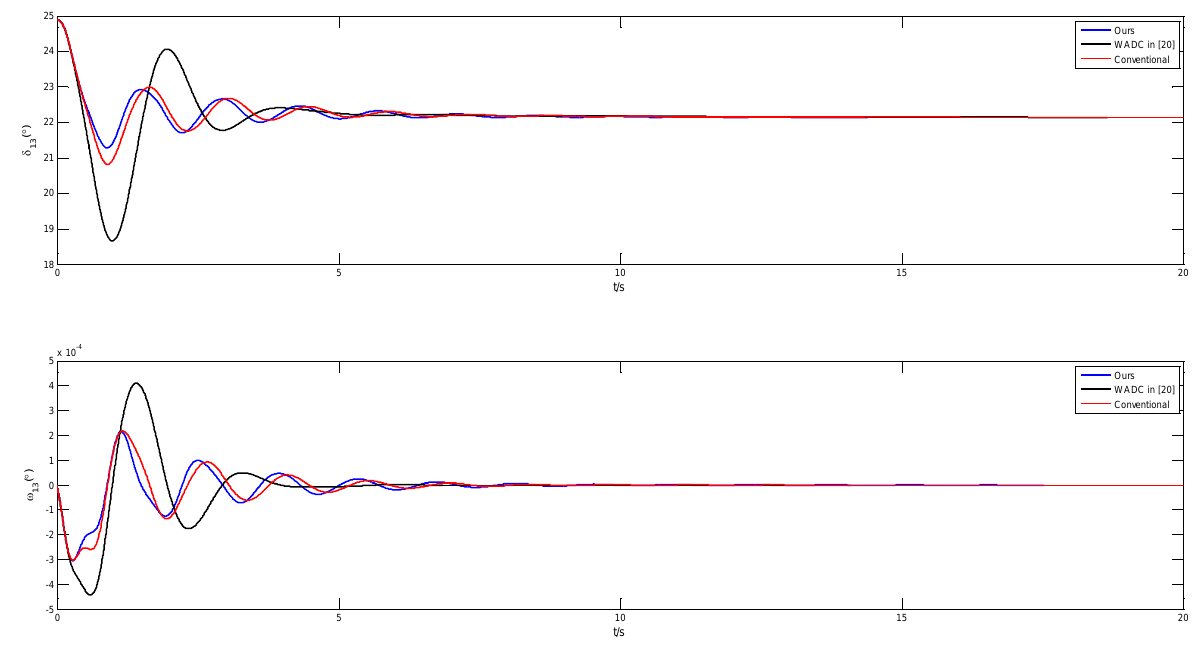
Figure 7. Response of the system in Scenario 3 when ρ = 0. Table 3. The key index of the response curve when there is no packet loss. Figure No. Controller Overshot (dec \ pu) Ours 33.464 \ 9.279 × 10 − 4 WADC in [20] 34.517 \ 9.859 × 10 − 4 Figure 5 Conventional 33.375 \ 9.267 × 10 − 4 Ours 25.156 \ 2.205 × 10 − 4 Figure 6 WADC in [20] 29.696 \ 7.538 × 10 − 4 Conventional 26.079 \ 8.759 × 10 − 4 Ours 24.900 \ 2.147 × 10 − 4 Figure 7 WADC in [20] 24.900 \ 4.099 × 10 − 4 Conventional 24.900 \ 2.169 × 10 −